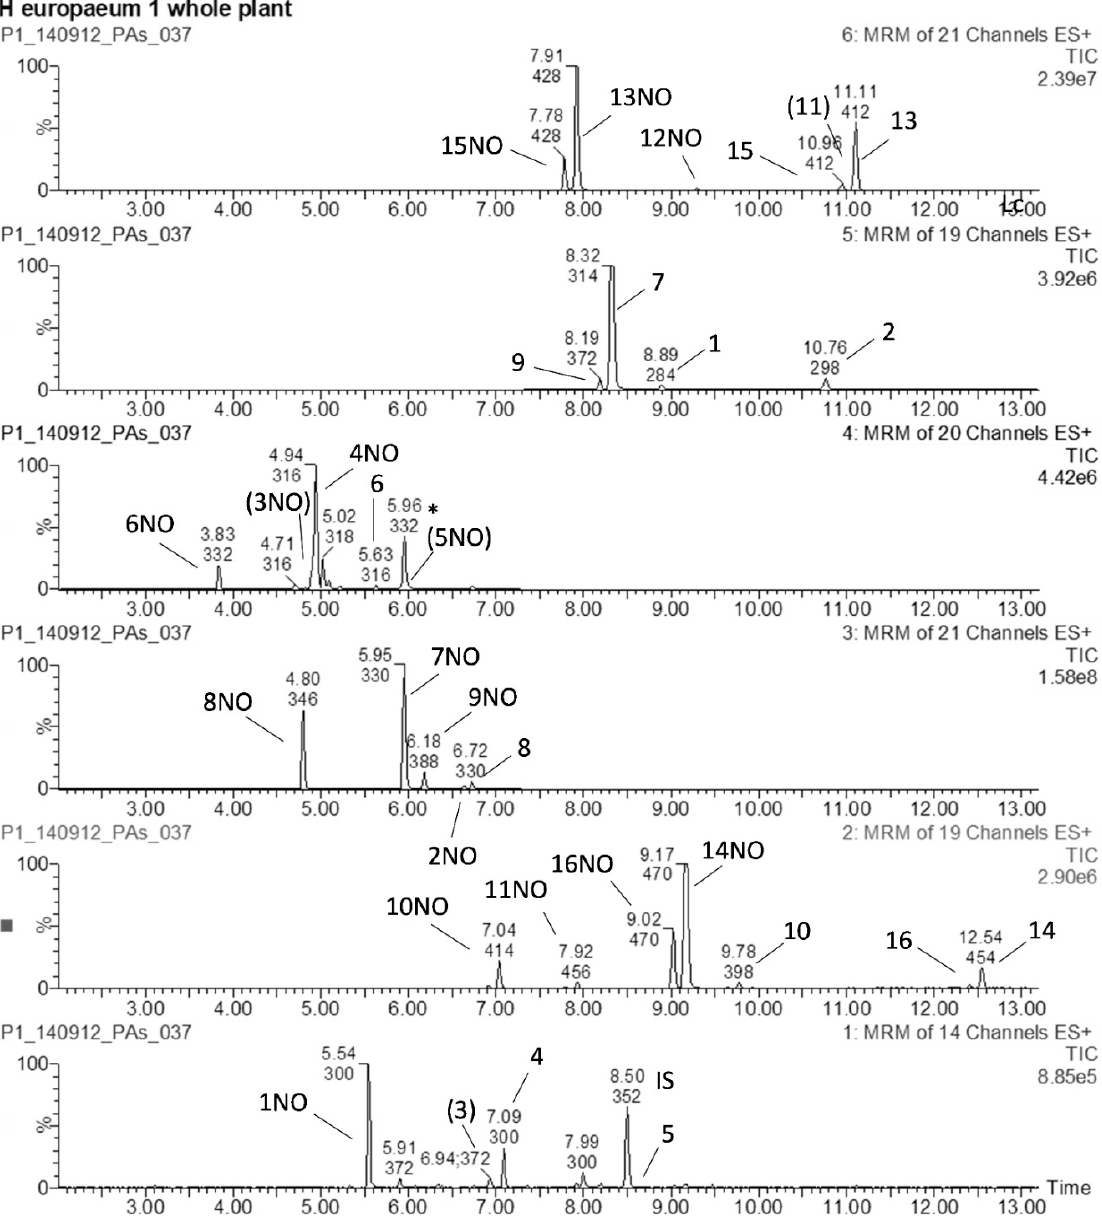
Figure 2. LC-MS/MS multiple reaction monitoring (MRM) chromatograms of a H. europaeum extract (whole plant). Annotation is as shown in Figure 1. NO = the N-oxide form. * denotes the 13 C2-isotopomer of 7NO. IS = internal standard. Compounds between brackets are masked in the chromatogram.